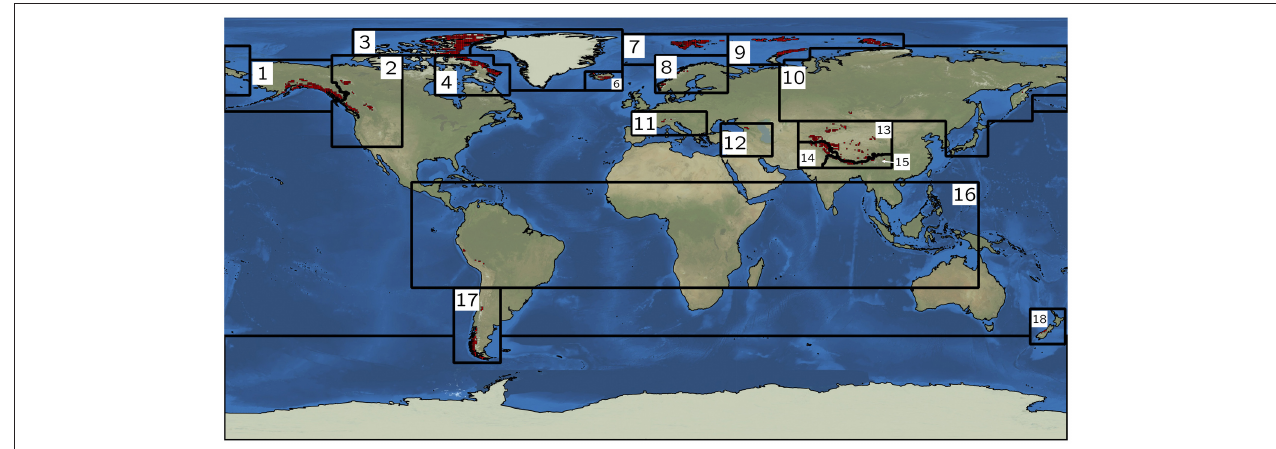
FIGURE 1 | Outlines of the RGI 6.0 regions, and location of the mascons used to retrieve the glacier mass loss from the GRACE data. Region names: 1: Alaska, 2: Western Canada and US, 3: Arctic Canada North, 4: Arctic Canada South, 6: Iceland, 7: Svalbard, 8: Scandinavia, 9: Russian Arctic, 10: North Asia, 11: Central Europe, 12: Caucasus and Middle East, 13: Central Asia, 14: South Asia West, 15: South Asia East, 16: Low Latitudes, 17: Southern Andes, 18: New Zealand.